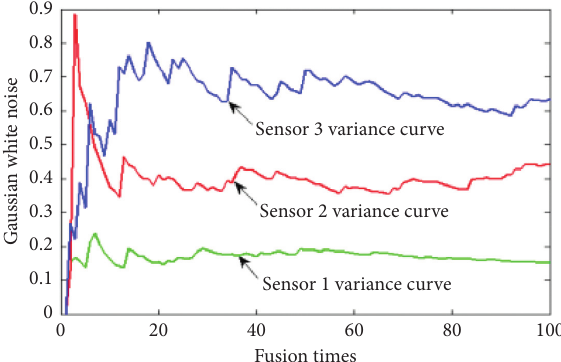
Figure 4: Variance changing curve of the data source before improvement.